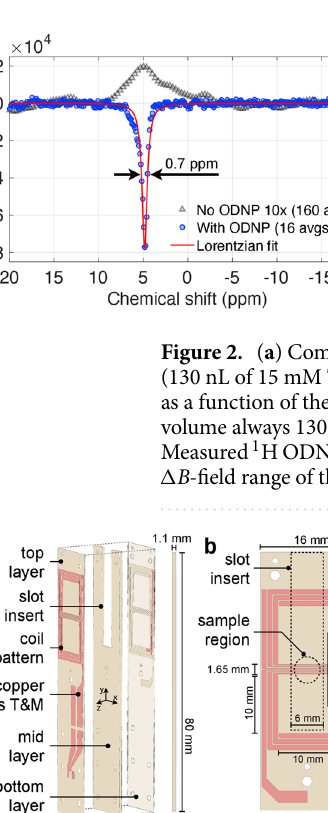
Figure 3. RF coil geometry and 3D EM field simulations at self-resonance (ca. 48 MHz). ( a ) Exploded view model of the stacked figure-8 coil. The total height of the pressed PCB stack is approximately 1.1 mm. 30 mm sized slot is milled into the mid layer spacer (ca. 0.8 mm in height) to accept the fluidic A 6 mm × insert featuring the MW resonator. ( b ) Zoomed-in details of the coil traces. The slot and sample region are indicated by dashed lines. ( c ) Density plot (top- and cross-sectional view) of the B y -field component, showing three distinct high magnetic field regions due to in-phase field superposition. ( d ) B y -field profiles along the y- y 0 ) of the coil, as well as normalised data shown over the sample region z 0 ) and z-direction ( x ( x = = = = (gray rectangles). Figure used with permission 41